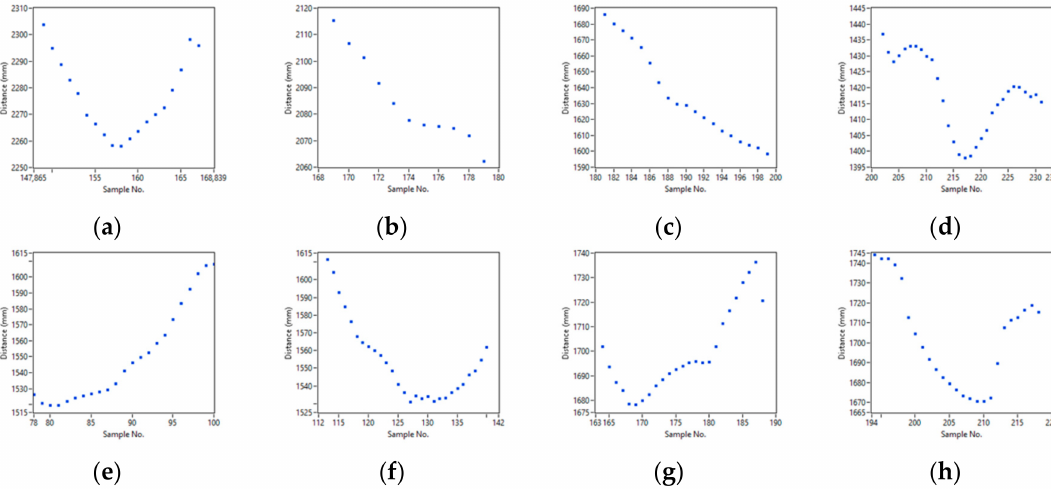
Figure 22. Scans of the detected leg region for: ( a – d ) walking straight-ahead, and ( e – h ) walking alongside.